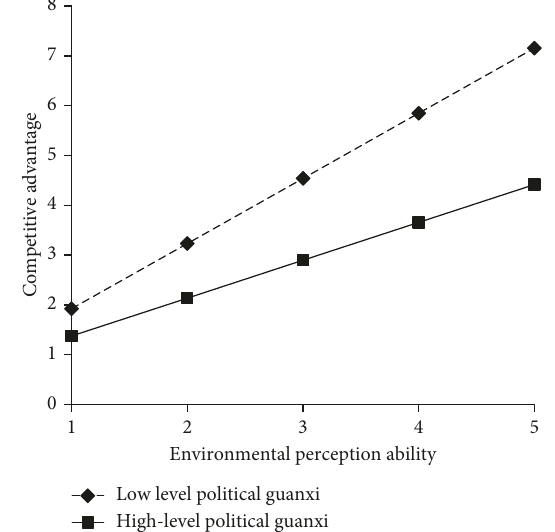
Figure 3: The interaction of environmental perception ability and political